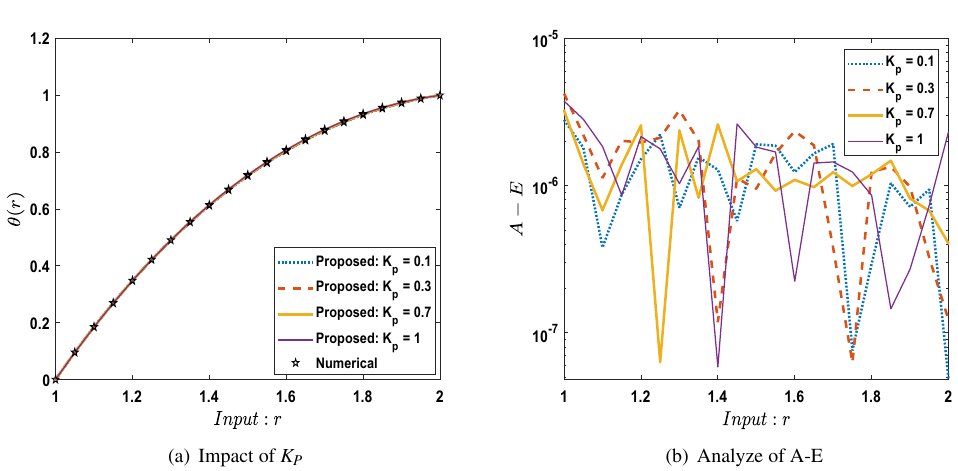
Figure 23. Comparison between LMA-TNN with results of numerical reference for scenario 3 in constant